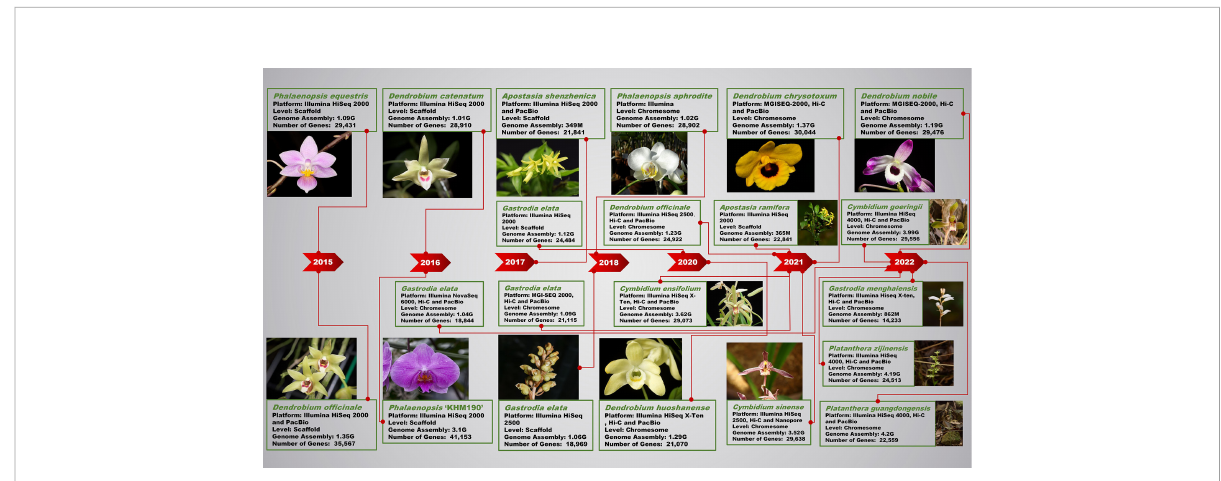
FIGURE 1 Research progress of next-generation sequencing and third-generation sequencing technology in orchid